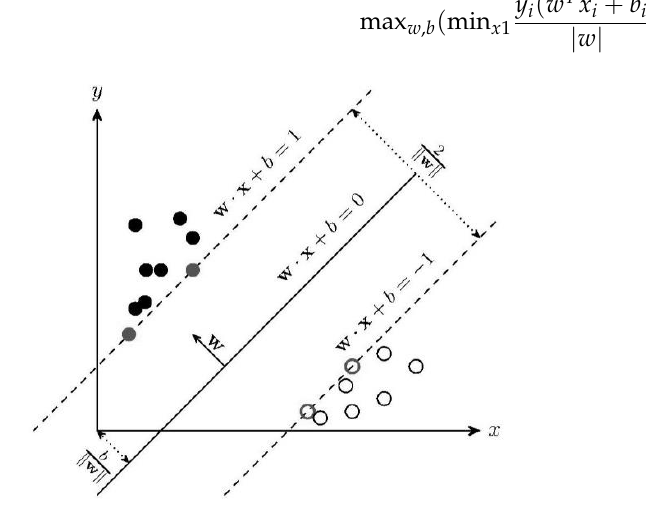
Figure 7. SVM principle.